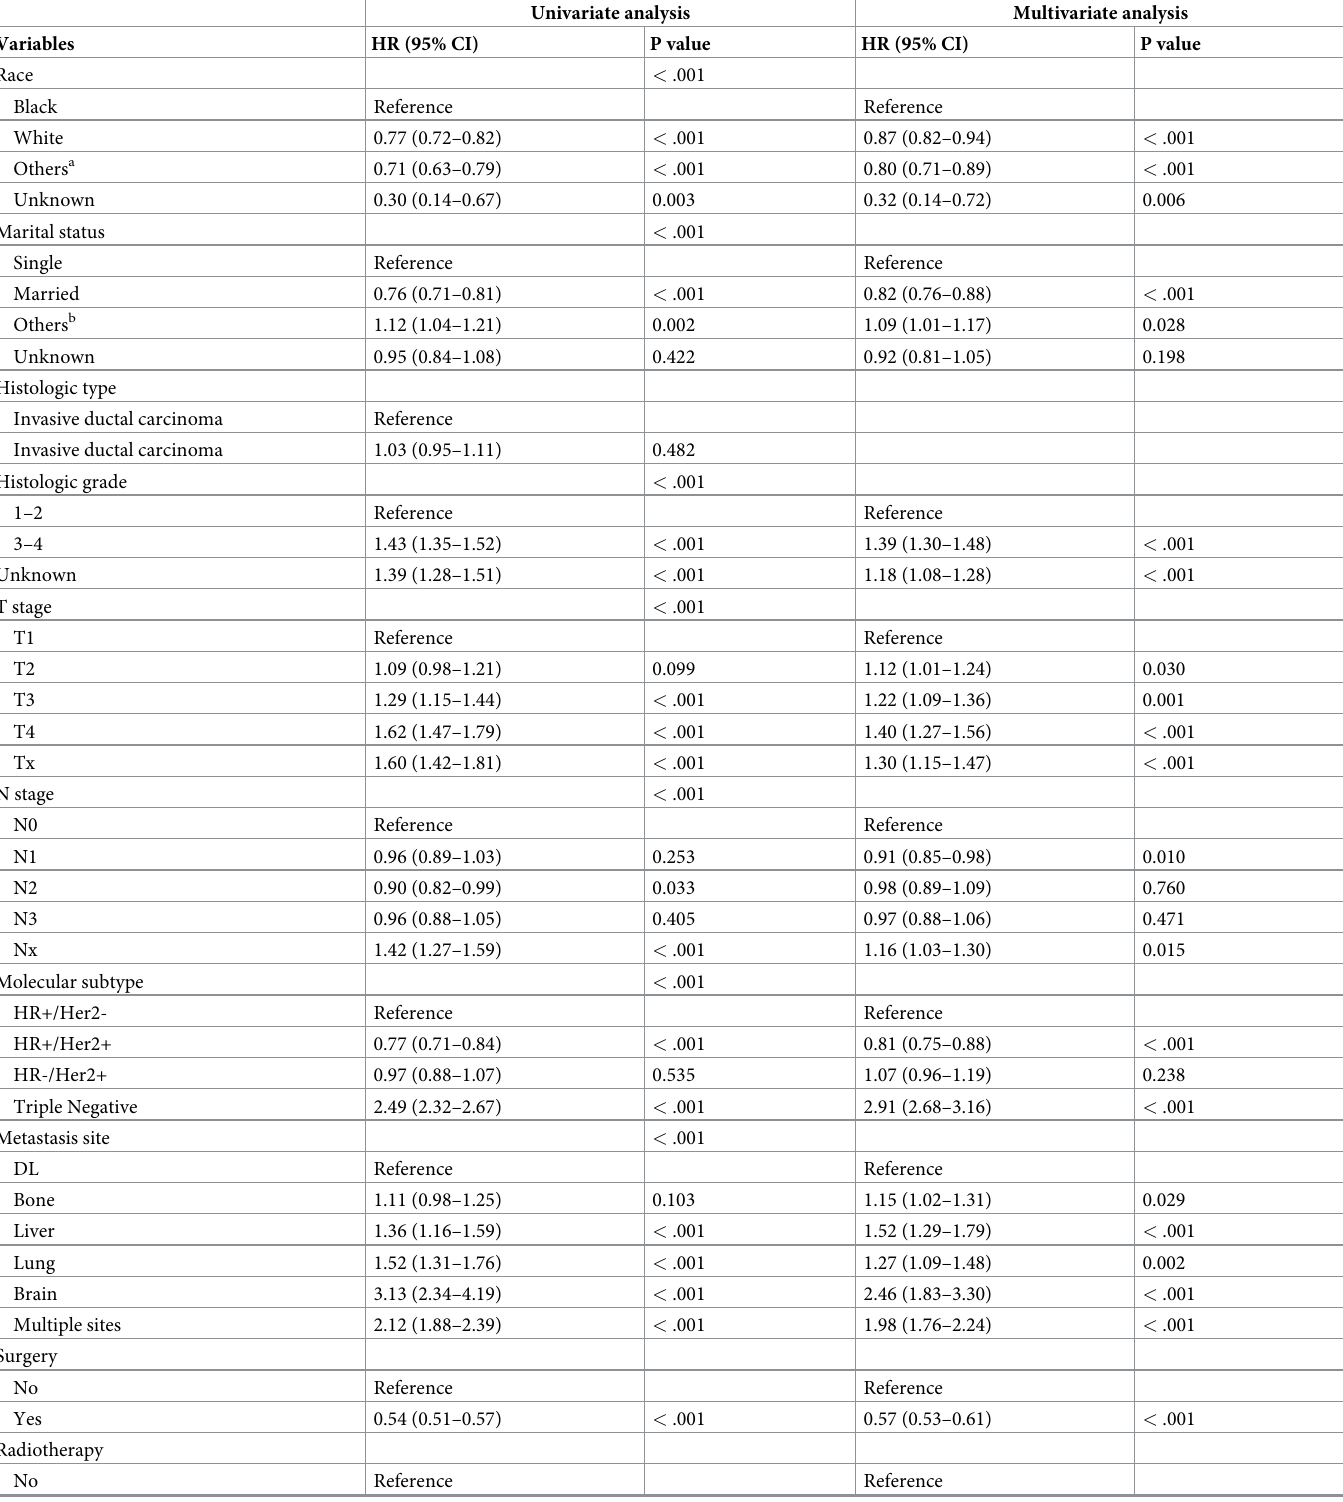
Table 4. Univariate analysis and multivariate analysis for cancer specific survival (CSS) among patients with metastatic breast